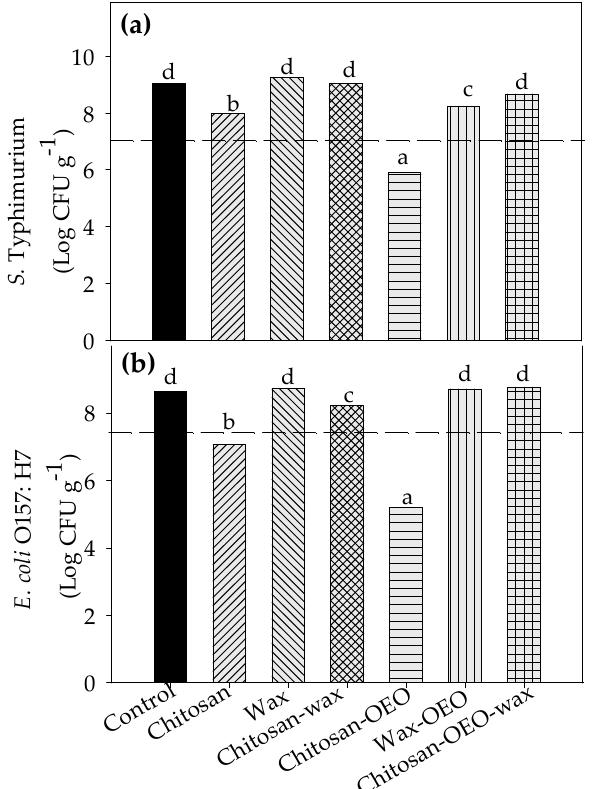
Figure 4. Antibacterial activity of chitosan, oregano essential oil (OEO), and carnauba wax films against S. Typhimurium ( a ) and E. coli O157:H7 ( b ) Dotted lines indicate the initial bacterial load, and different letters among bars indicate significant differences ( p ≤ 0.05).